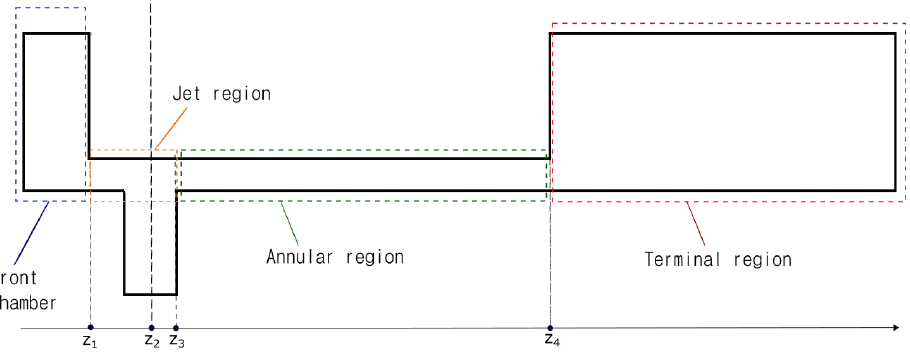
Figure 8. Gripper body subregions.